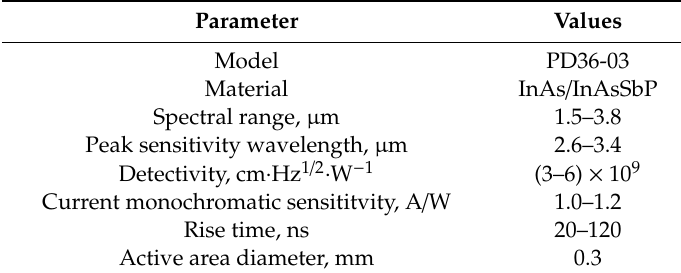
Table 4. Main parameters of photodiode.